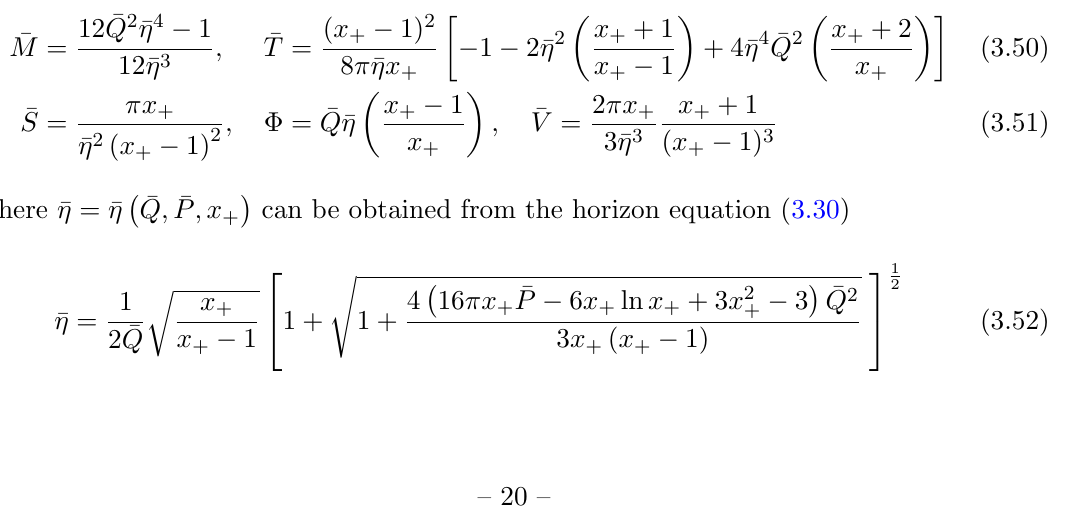
Figure 14 . The left hand side depicts simultaneously the two surfaces corresponding to the conditions for criticality ((cid:12)gure 13); the surface in yellow corresponds to (cid:0) (cid:1) surface in green to @ (cid:22) P 2 =@ (cid:22) v 2 = 0. The intersection occurs inside the interval 1 = (cid:8) ; (cid:22) T which is shown in the right hand side, in the ((cid:22) v , x + )